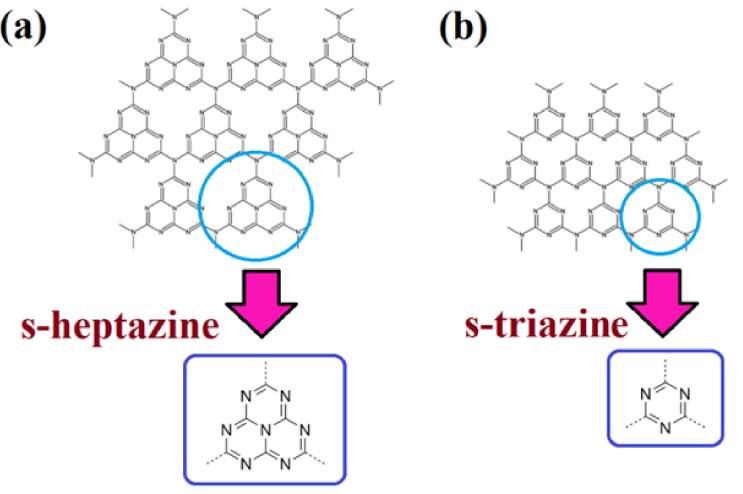
Figure 3. The structures of ( a ) s-heptazine; and ( b ) s-triazine unit. Reproduced with permission from Ref.